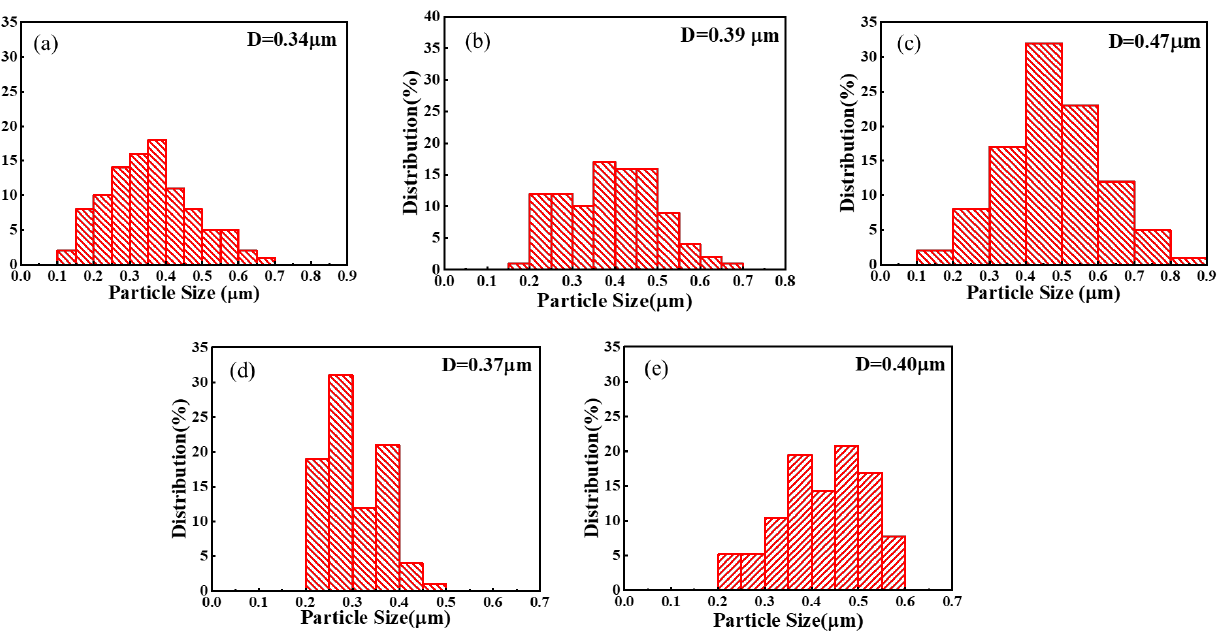
Figure 6. Influence of molecular weight on size distribution of the dispersed phase: ( a ) LC4/LA(70/30); ( b ) LC4/MA(70/30); ( c ) LC4/HA(70/30); ( d ) MC4/LA(70/30); ( e ) HC4/LA(70/30).